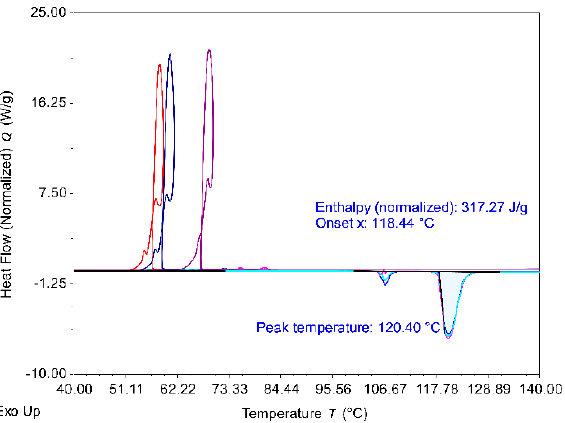
Figure 4. DSC thermograms (3 cycles) obtained in ramp mode at a heating/cooling rate of 5 K/min for erythritol.